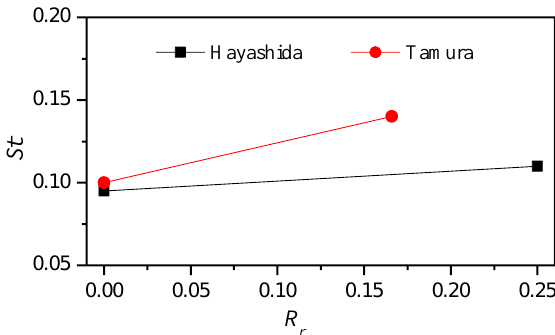
Figure 13. St number of rounded model by existing studies [14,20].